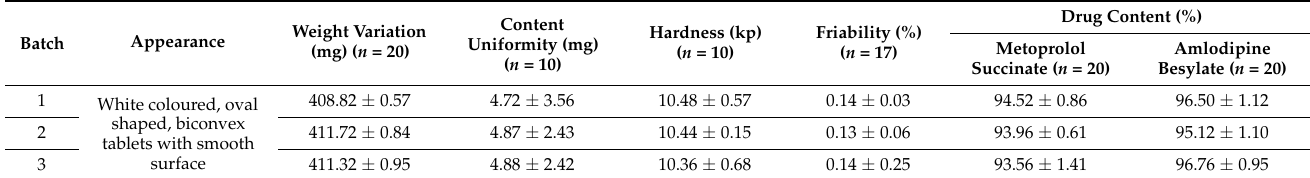
Table 10. Evaluation of film coated bi-layer tablet of three batches.